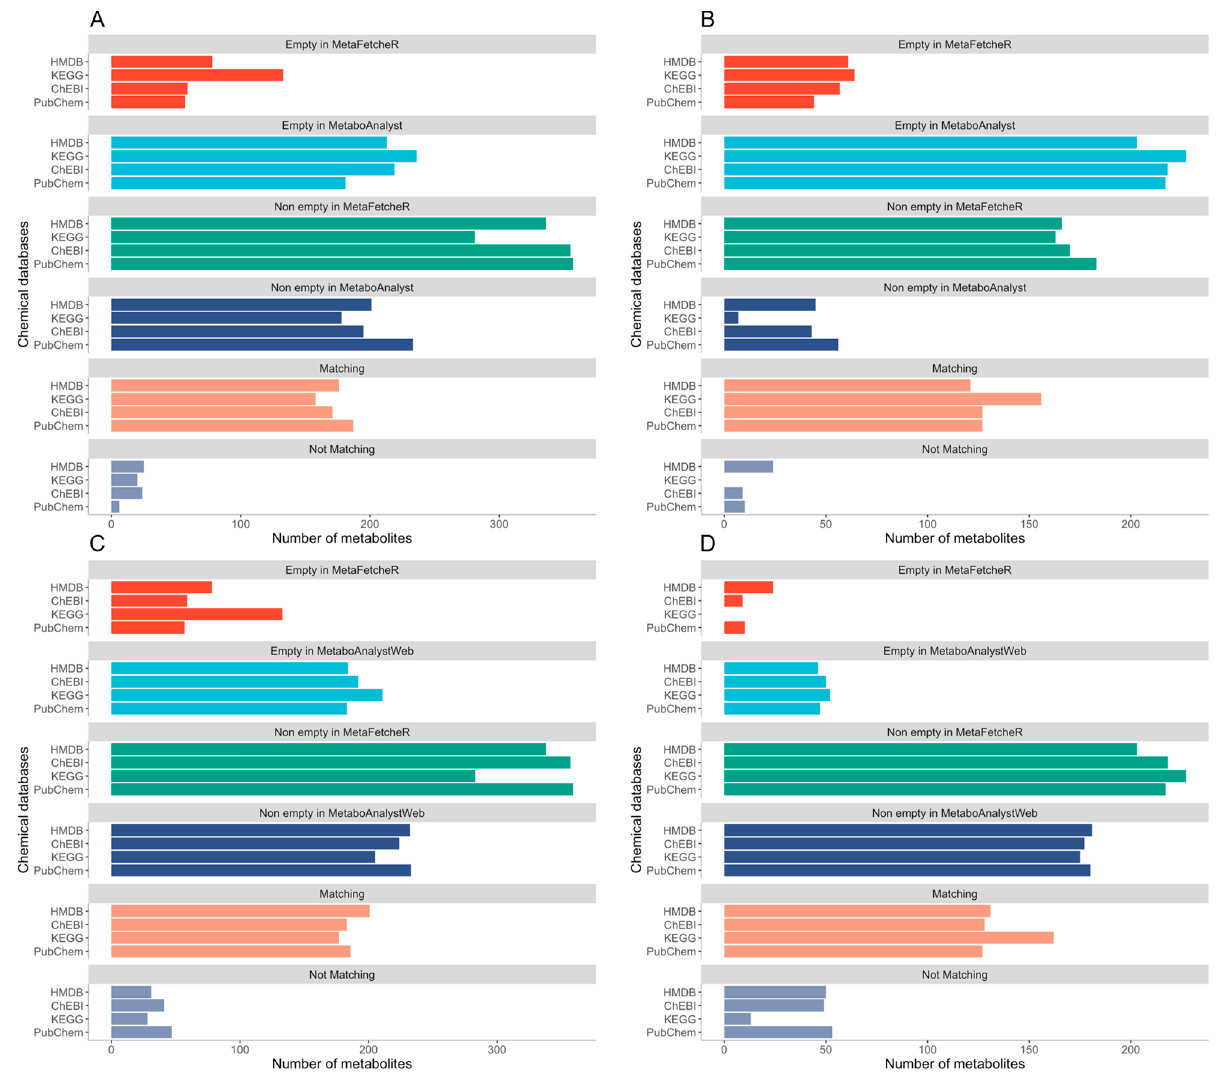
Figure 2. Comparison of the mapping performance of MetaFetcheR to MetaboAnalystR and MetaboAnalyst 5.0 webtool. ( A ) Comparison of the mapping performance for MetaFetcheR and MetaboAnalystR on Diamanti et al.’s [1] dataset, ( B ) Comparison of the mapping performance for MetaFetcheR and MetaboAnalystR on Priolo et al.’s [12] dataset, ( C ) Com- parison of the mapping performance for MetaFetcheR and MetaboAnalyst 5.0 webtool on Diamanti et al.’s [1] dataset, ( D ) Comparison of the mapping performance for MetaFetcheR and MetaboAnalyst 5.0 webtool on Priolo et al.’s [12] dataset. Empty in the MetaFetcheR and MetaboAnalyst or MetaboAnalystWeb panels illustrates the number of identifiers that could not be mapped using the respective tool. Non-empty in the MetaFetcheR and MetaboAnalyst or MetaboAnalystWeb panels presents the number of identifiers that were successfully mapped using the respective tool. Matching panel shows the number of mapped identifiers that agreed between tools. Non-matching panel shows the number of mapped identifi- ers that were not in agreement between tools. The number of identifiers is shown on the x-axis.